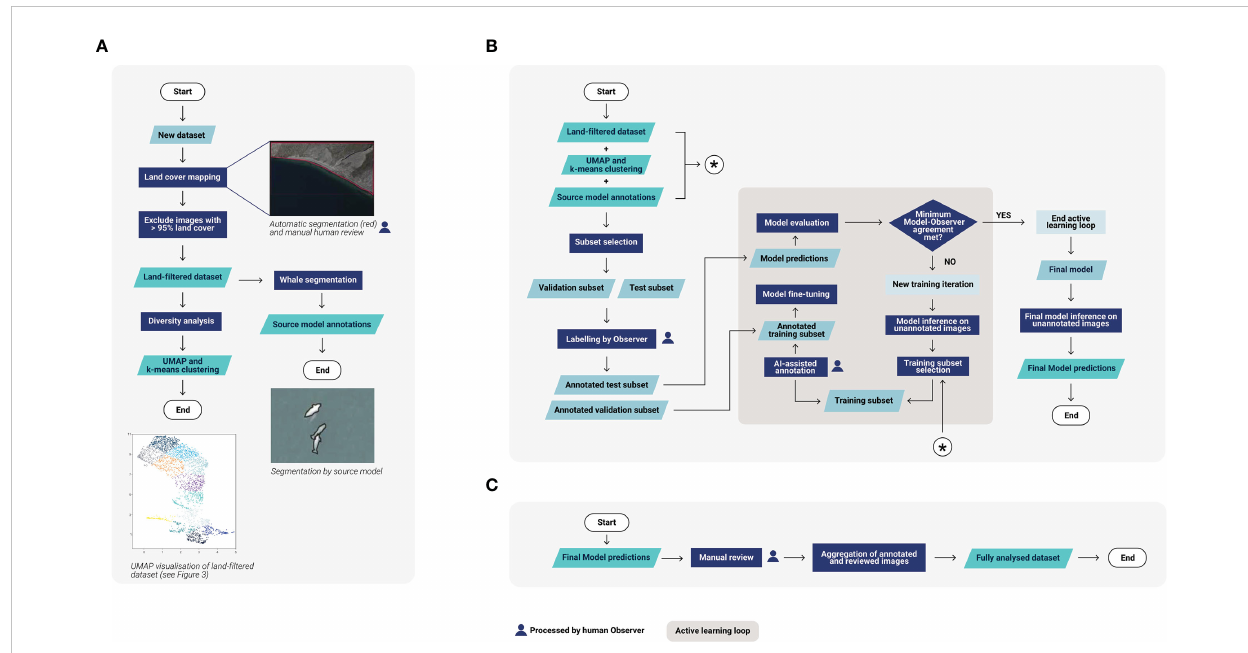
FIGURE 2 Overview of the human-in-the-loop pipeline. The pipeline is divided into three main stages: (A) The preliminary analysis, (B) The active learning loop, (C) The human review of the